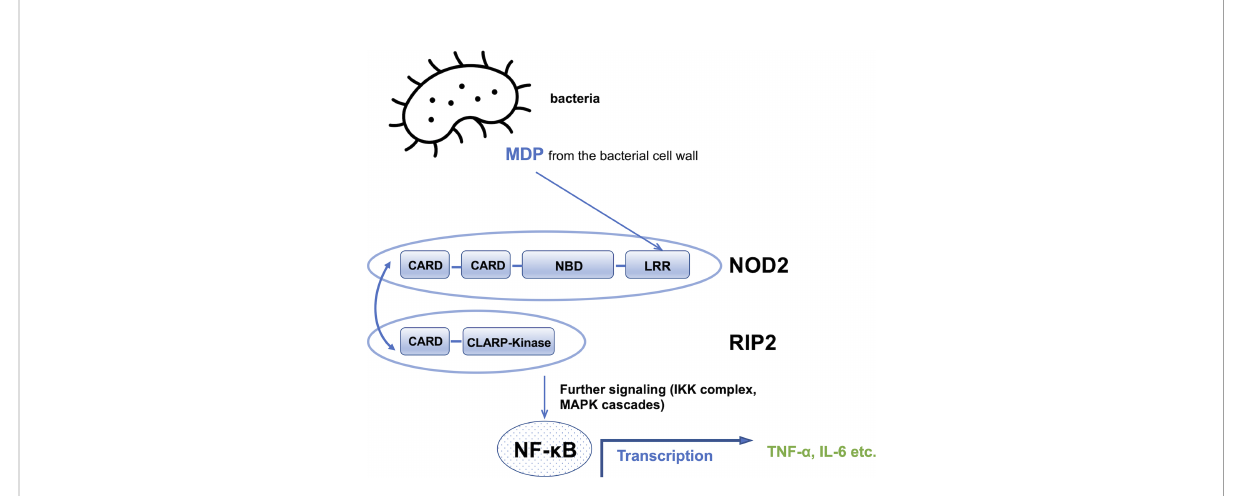
FIGURE 2 Schematic of the MDP signaling pathway. CARD, caspase recruitment domain; NBD, nucleotide binding domain; LRR, leucine rich repeats domain, NF-kB, nuclear factor kappa-light-chain-enhancer of activated B cells; TNF ∝ , tumor necrosis factor; IL-6, interleukin